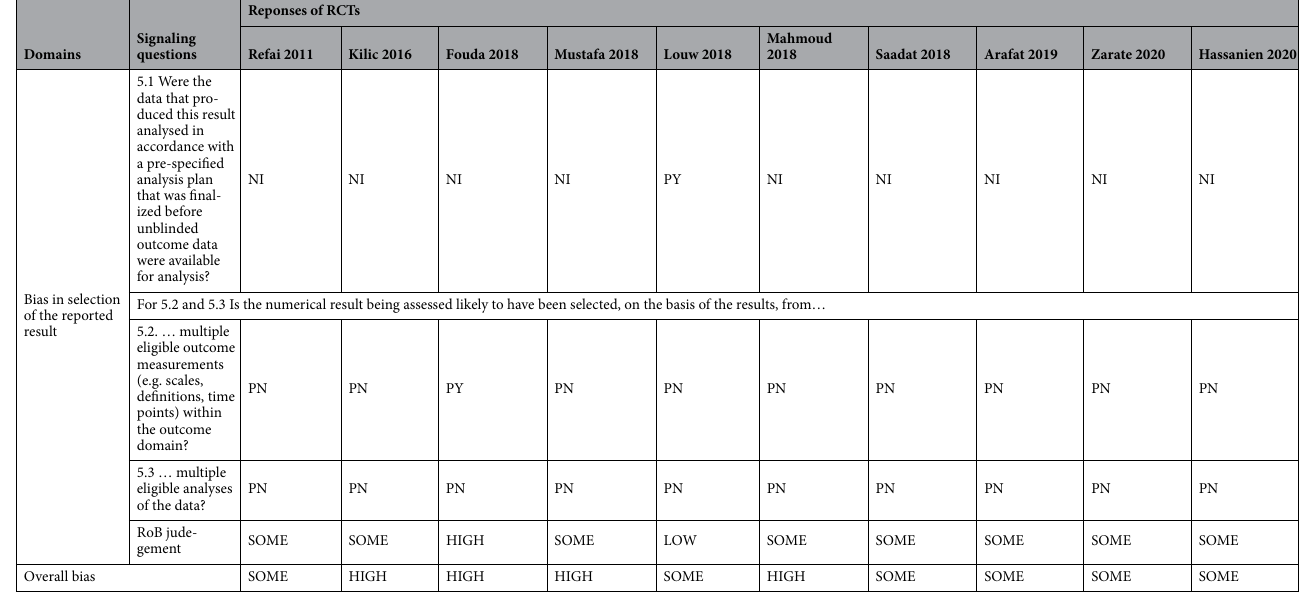
Table 2. Details of signaling questions in each domain of risk of bias assessment for 10 randomized controlled trials. HIGH high risk of bias, LOW low risk of bias, N no, NA not applicable, NI no information, PN probably no, PY probably yes, RCTs randomized controlled trials, RoB risk of bias, SOME some concerns, Y yes.